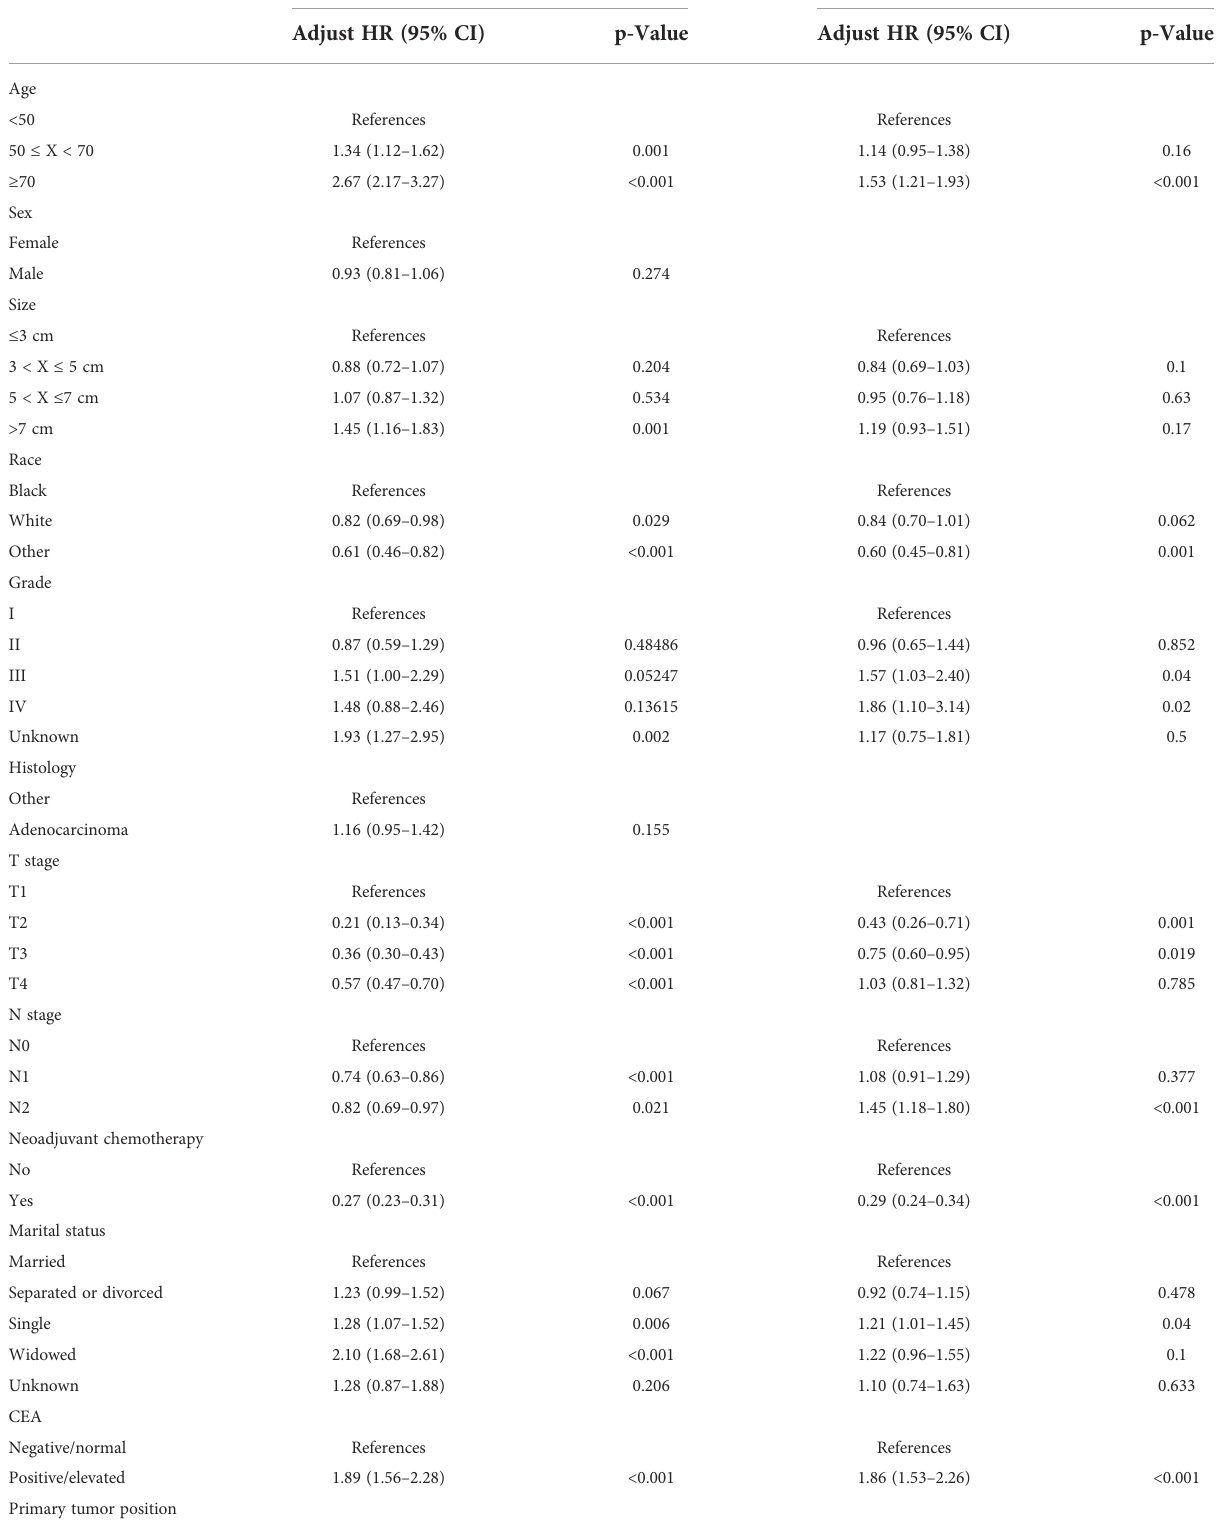
TABLE 1 Univariable and multivariate Cox analyses for CSS among CRLM